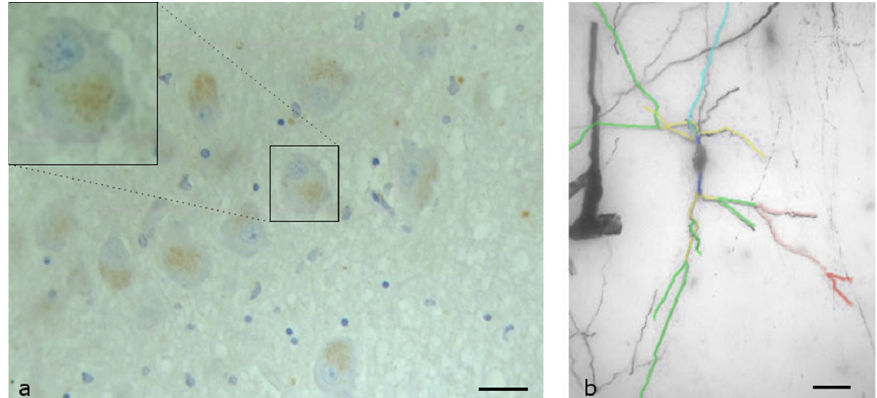
Figure 2. Lateral Preoptic Nucleus of human Hypothalamus: ( a ) Immunohistochemical staining, specific for OX1R. Almost all neurons (more than 95%) express OX1R but in lower quantities. The OX1Rs appear as cytoplasmic granules, clustered near the cell membrane (Scale bar, 25 μ m); ( b ) A Golgi-stained neuron mapped by the ImageJ program. Primary (dark blue), secondary (yellow), tertiary (green), quaternary (pink) and even quinary (red) dendrites can be found. Light blue depicts the axon of the neuron (Scale bar, 30 µ m).